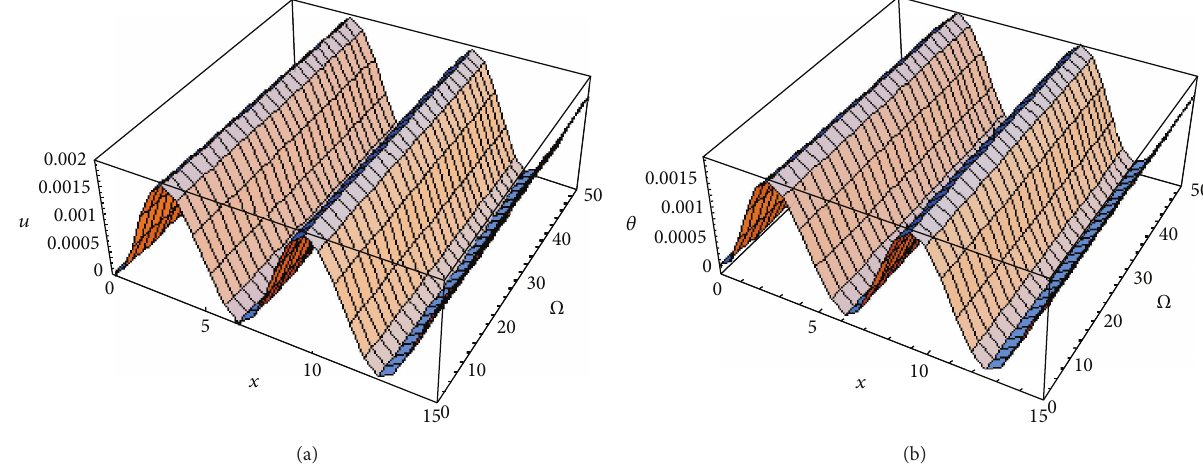
Figure 4: Variations of the displacement 𝑢 and the temperature 𝜃 for various values of the 𝑥 -axis and rotation Ω when 𝑡 = 0.1 , 𝜏 2 = 0 , 𝜏 1 = 0.1 , = 0.2 , 𝜎 = 0.1 , and 𝜔 = 0.02 . 𝛿 = 1 , 𝜎 1 2